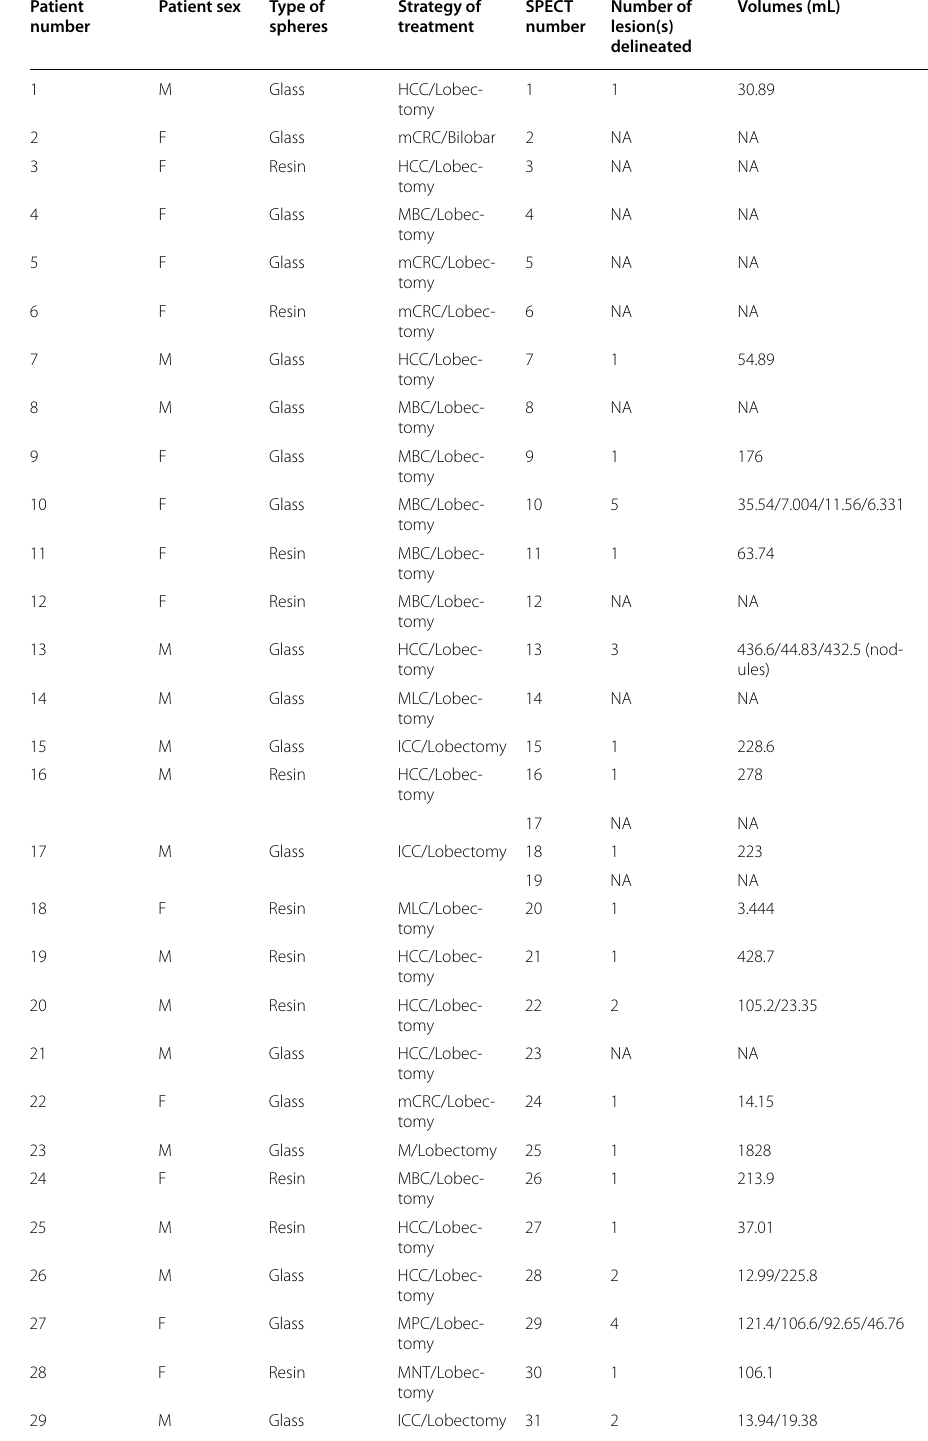
Table 1 Characteristics (sex, type of sphere, number of lesions, their volumes and strategy of treatment) of patients included in this